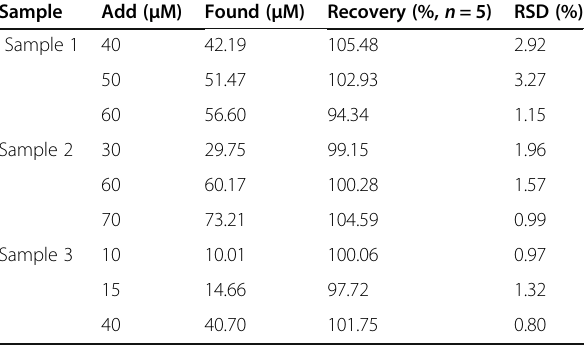
Table 1 Detection of berberine hydrochloride in blood samples Sample